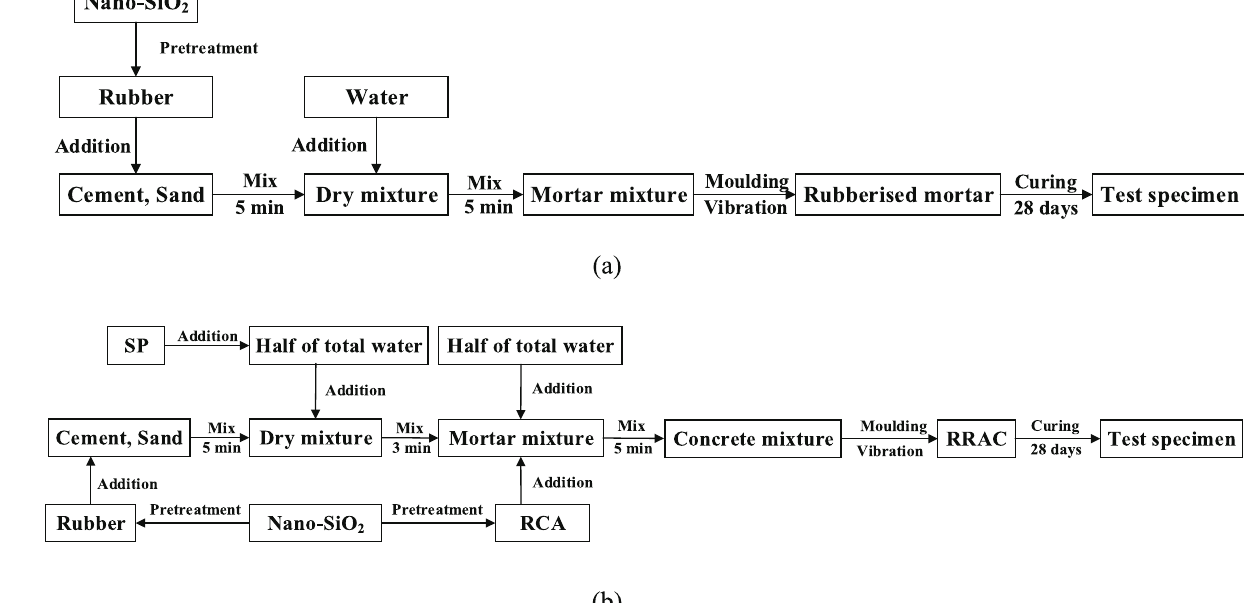
Mix proportions ( unit weight: kg/m 3 )